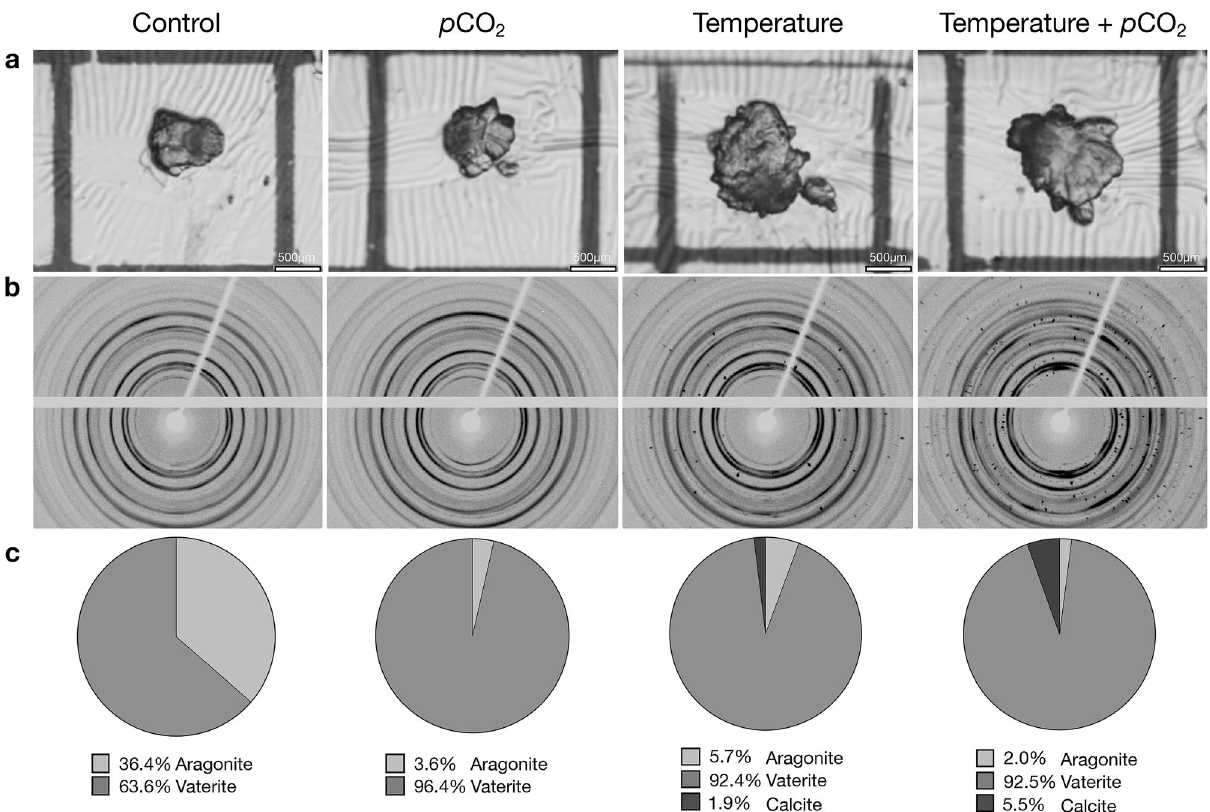
μatm p CO 2 ], temperature [22 °C, 1000 μatm p CO 2 ], temperature + p CO 2 [22 °C, 2500 μatm p CO 2 ]) including ( a ) images of sagittal otoliths at ×10 magnification, ( b ) Debye–Scherrer diffraction patterns collected using X-ray microdiffraction, and ( c ) percent polymorph composition (i.e., aragonite, vaterite, calcite) by otolith weight. Examples were chosen to highlight the variability in otolith polymorph composition observed